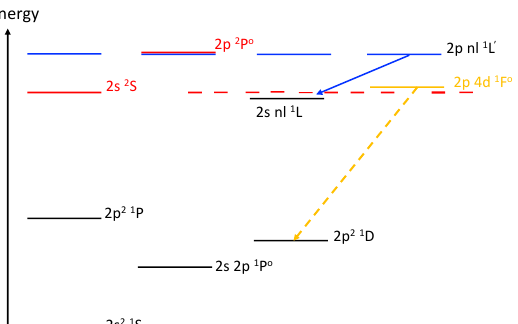
Figure 4. Simplified pseudo-Grotrian diagram for C III and C IV to help illustrate LTDR and HTDR. Five bound C III levels are shown in black and two C IV levels are shown in red. Example HTDR autoionizing levels (e.g., 2p 50p, 2p 50d, etc.) that converge on the C IV 2p 2 P o state are shown in blue. One of the most important LTDR autoionizing levels is shown in orange—it has been moved up slightly in energy to separate it more clearly from the C IV ground state—the horizontal dashed red line is used to indicate the energy of the C IV ground state. The blue line shows a HTDR transition, which has a wavelength approximately equal to that of the C IV resonance transitions (1548, 1551 Å), while the dashed orange line shows a LTDR transition (at ∼ 412Å). Triplet levels also experience both LTDR and